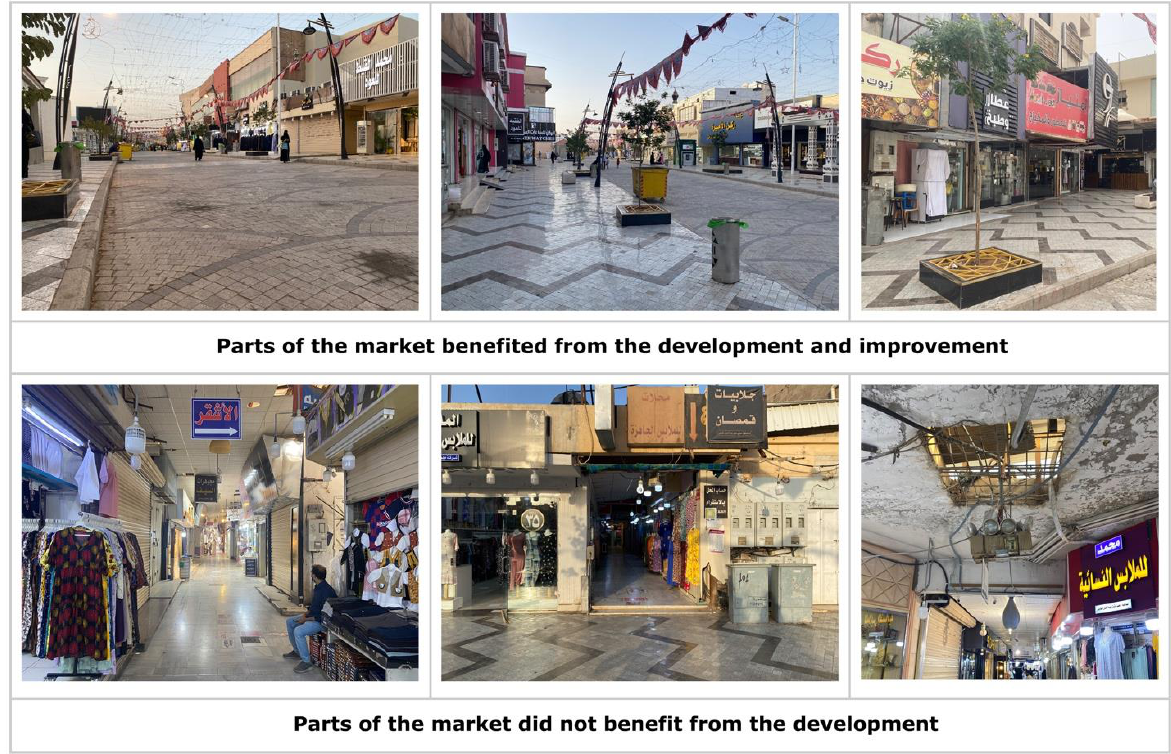
Figure 16. The different degrees of Barzan development and improvement. Source: Authors.